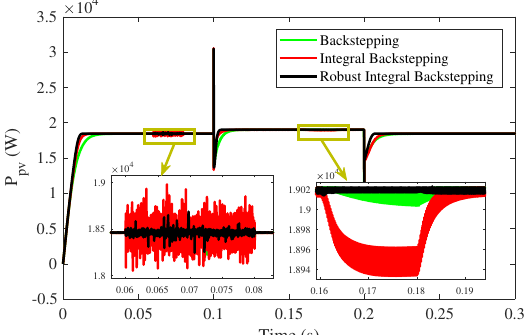
Figure 21. Output power of PV array with multiple uncertainties under varying temperature and irradiance.